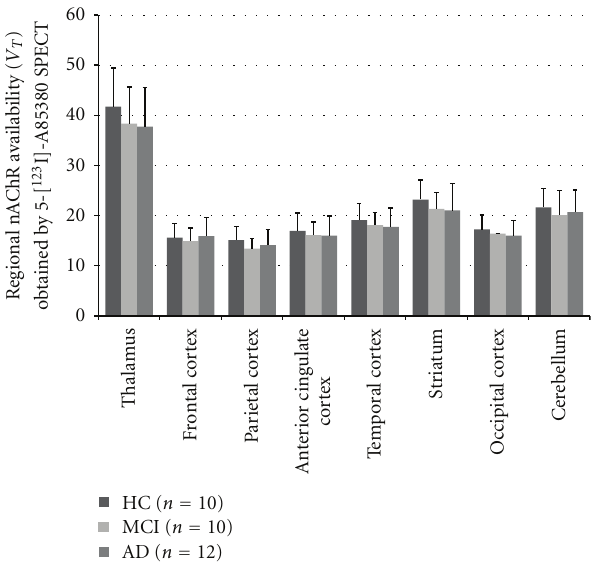
Figure 4: Regional α 4 β 2-nAChR availability ( V T ) of 5-[ 123 I]I- A85380 in age-matched healthy control (HC), mild cognitive impairment (MCI), and Alzheimer’s disease (AD) groups. No significant regional di ff erences among the subject groups for any of the 8 regions, including the 4 neocortical regions, were identified. (Data is from the paper of Mitsis et al.